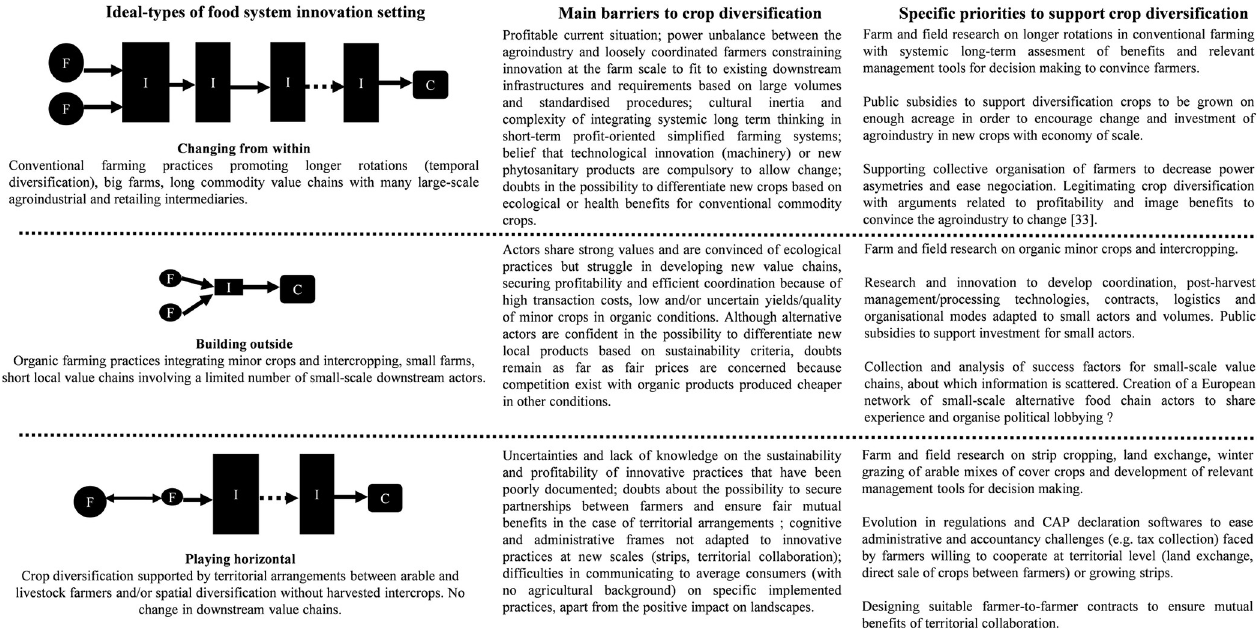
PLOS ONE | https://doi.org/10.1371/journal.pone.0229910 March 12,